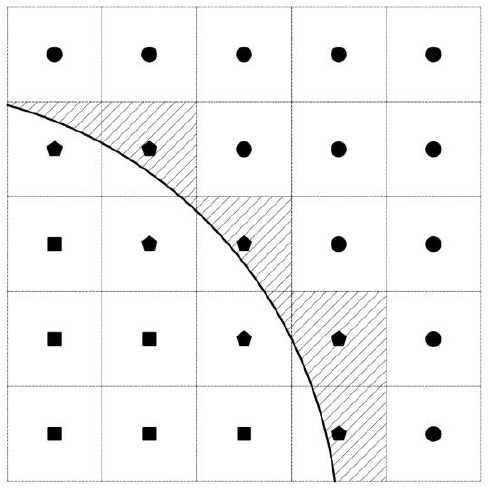
Figure 3. Cell type of immersed moving boundary (IMB) method.